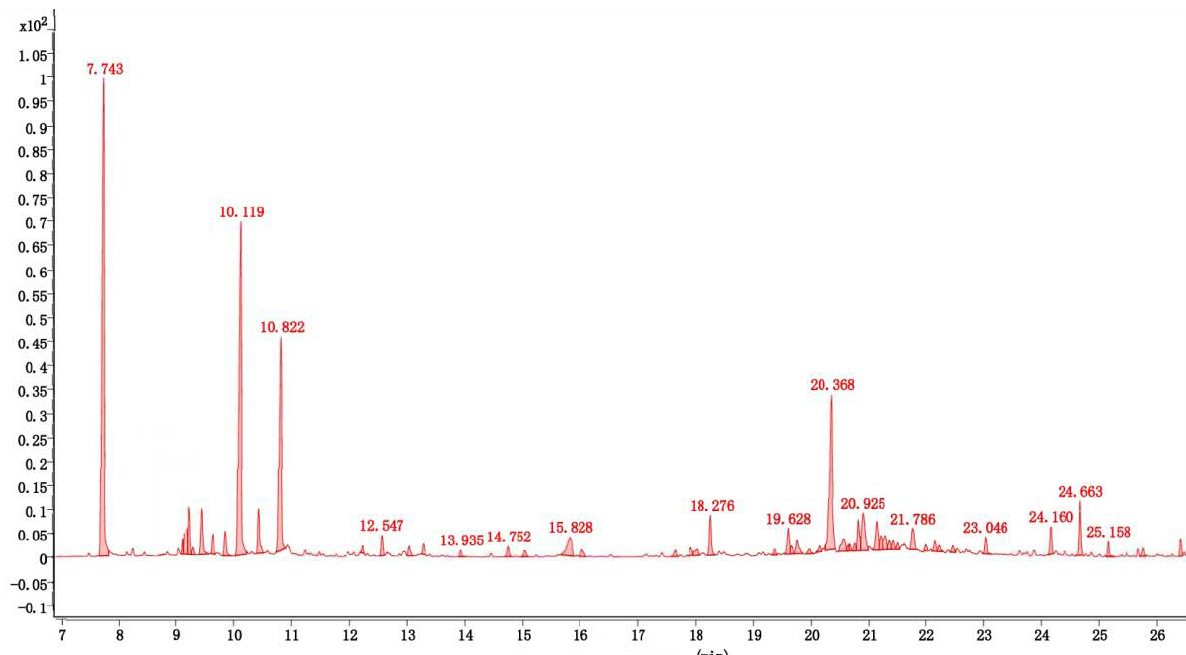
the homologous series of n -hydrocarbons. 3 Co, co-injection with authentic compound. 4 CAS, Chemical Abstract Service.